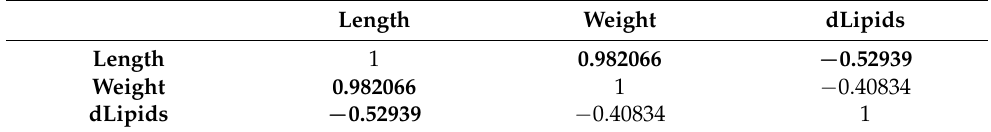
Table 2. Pearson correlations between lipid density ( µ m 2 /mm 2 ) and fish biological parameters (LJFL and TW) ( N = 50). Significant correlations ( p < 0.05) are displayed in bold.